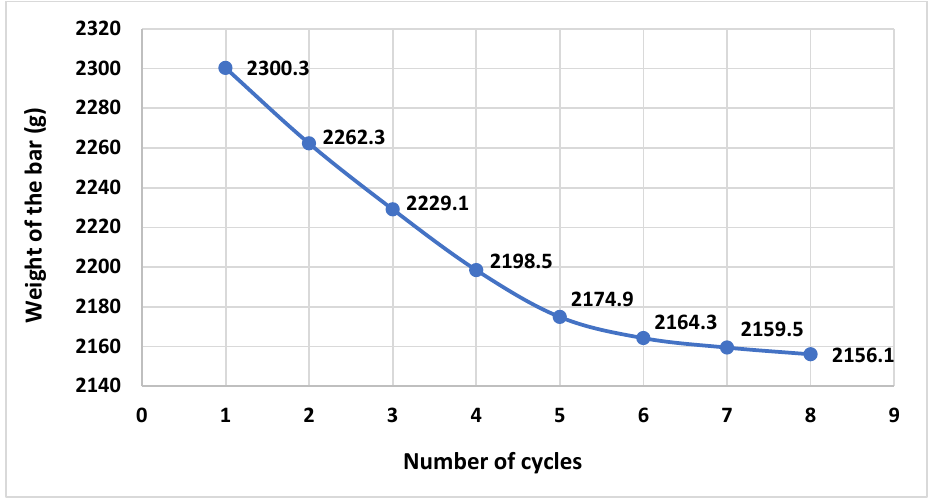
Figure 8. Change in weight loss for beam B with number of cleaning cycles.